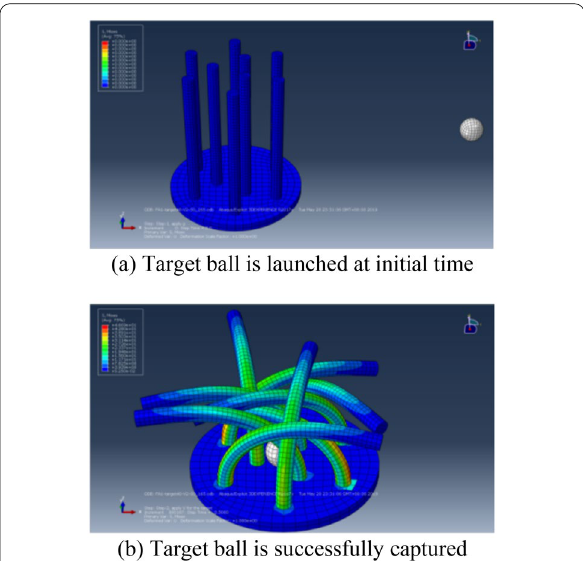
Figure 5 Capture of a target ball in FEM simulation